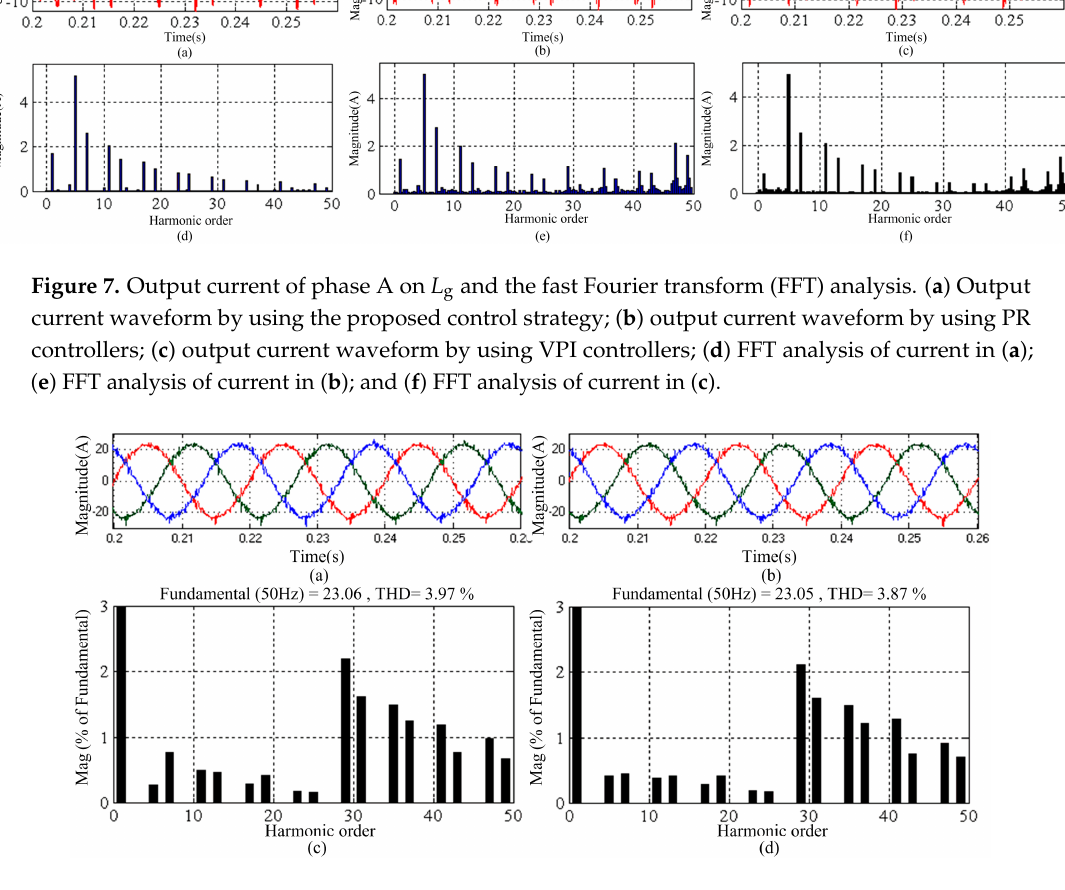
Figure 8. Grid current of phase A and the FFT analysis. ( a ) Grid current waveform by using PR controllers; ( b ) grid current waveform by using VPI controllers; ( c ) FFT analysis of current in ( a ); and ( d) FFT analysis of current in ( b ).